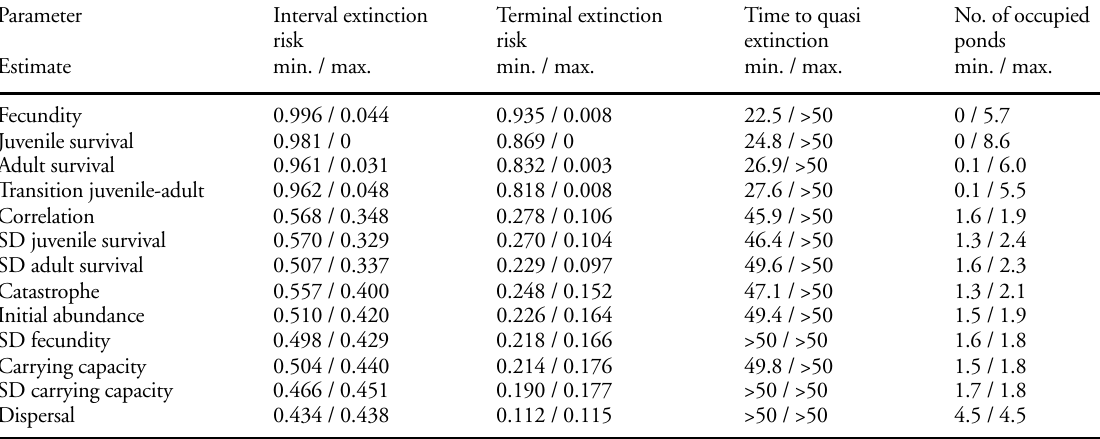
Table 4. The sensitivity of different parameters for the model outcome. Sensitivity is expressed as the extinction risk at a minimum and maximum estimate, respectively, of a parameter when all other parameters are set at the medium estimates. Extinction risk is expressed as the probability of a quasi-extinction in the study area (the population size in each of the populations in the study area falling below 10 females [adults + juveniles]) at least once during 50 years (interval extinction risk); the probability that the great crested newt in the study area will end up quasi-extinct after 50 years (terminal extinction risk); the median time to quasi-extinction in the study area in years (time to quasi-extinction); the average number of occupied ponds in the study area after 50 years (no. of occupied ponds). The parameters are arranged in falling order by sensitivity in terminal extinction